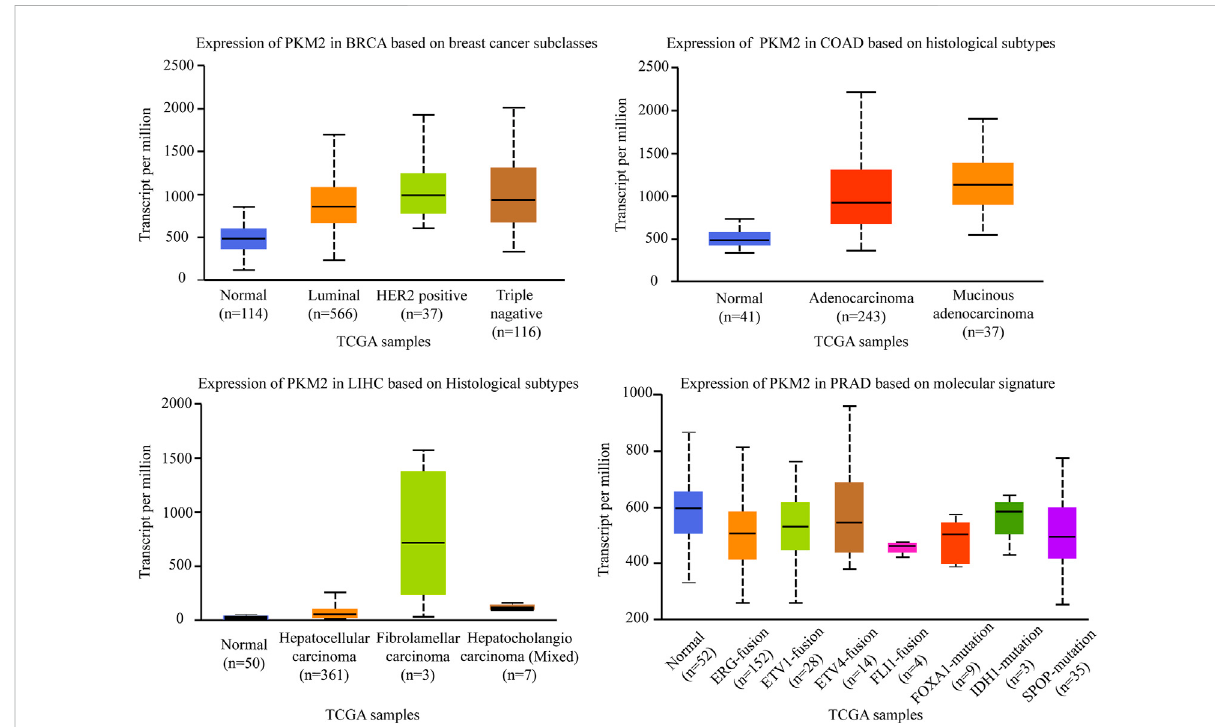
FIGURE 4 Association ofPKM2geneexpressionwithhistologicalsubtypesand molecular signatureindifferentcancers.BRCA,breastinvasive carcinoma. COAD, colon adenocarcinoma. LIHC, liver hepatocellular carcinoma. PRAD, prostate